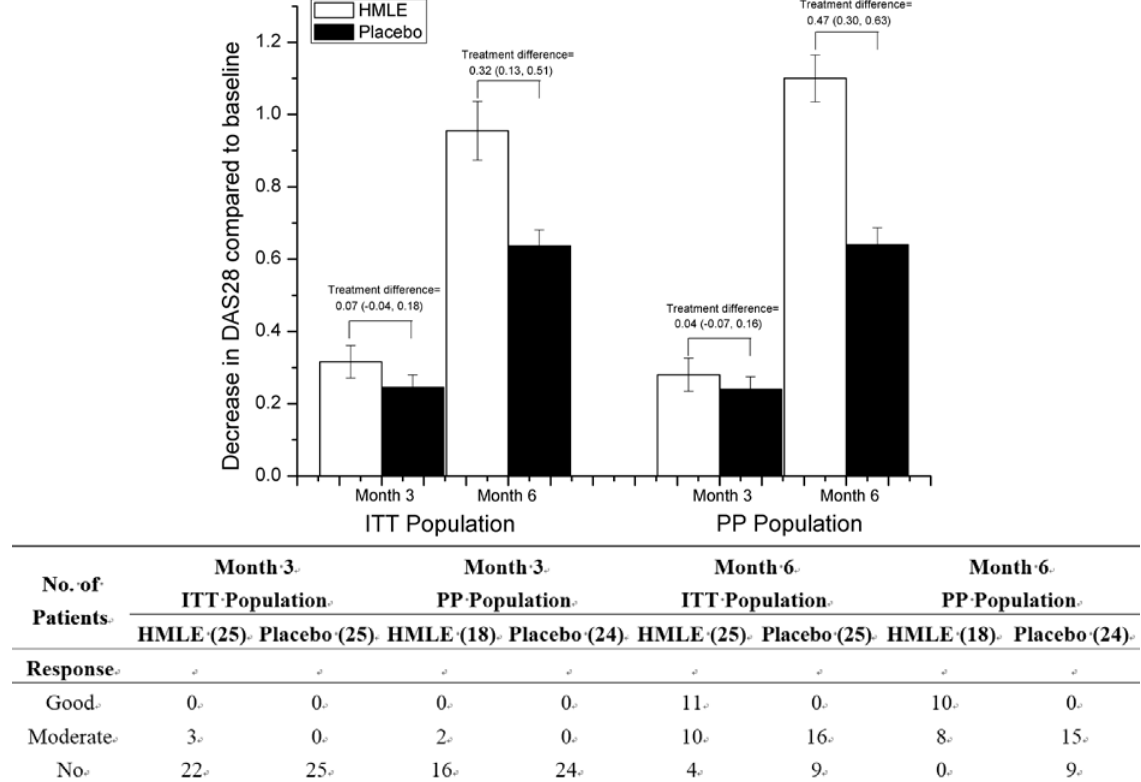
Figure 2. Changes over time in the Disease Activity Score (DAS28), and number of patients achieving good or moderate response to intervention based on DAS28. Error bars represent